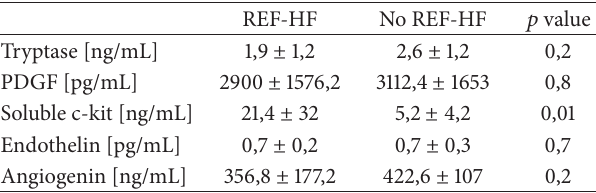
Table 6: The differences in tryptase, PDGF, soluble c-kit, ET-1, and angiogeninlevelsbetweenREF-HFandnoREF-HFSTEMIpatients. The analysis was made using 𝑡